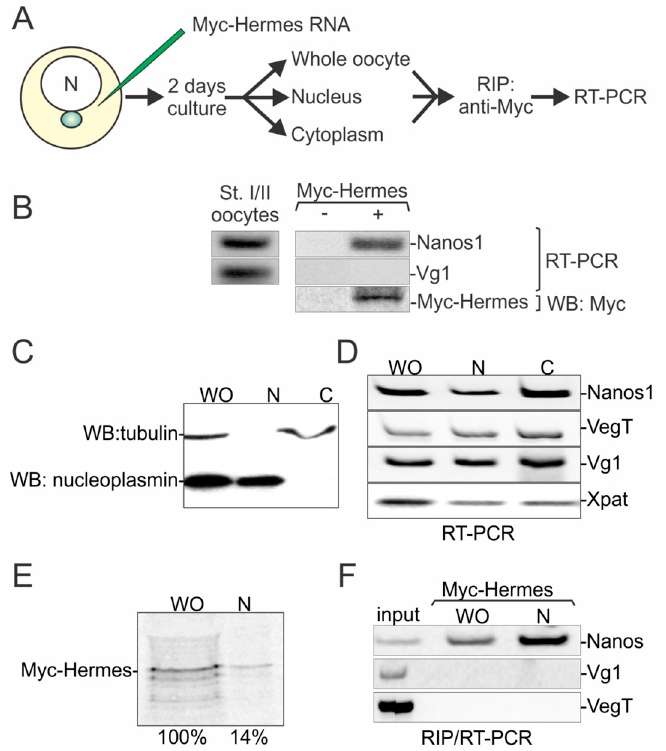
Figure 6. Hermes/Rbpms associates with nanos but not Vg1 RNA in the nucleus. ( A ) Overall experimental design. Myc-Hermes/Rbpms mRNA was injected into stage I/II oocytes. After culturing for two days, either myc-Hermes/Rbpms protein was immunoprecipitated (IP) with anti-myc antibody from whole oocytes only or the nuclear (N) and cytoplasmic (C) fractions were manually isolated before IP with anti-myc antibody. In either design, RNA was extracted from the resulting pellet and analyzed with specific primers for Vg1 or nanos RNA by RT-PCR; ( B ) Myc-Hermes/Rbpms interacts with nanos but not Vg1 RNA in vivo . Control RT-PCR with whole oocytes shows that nanos and Vg1 RNAs were present. Control western blot shows that myc-Hermes/Rbpms was translated after injection; ( C ) The nuclear and cytoplasmic fractions were manually isolated from stage I/II oocytes. Tubulin (cytoplasmic marker) and nucleoplasmin (nuclear marker) were detected by western blot analysis and show clean separation; ( D ) Late and Early Pathway RNAs accumulate in nucleus concurrently. RNAs were analyzed by RT-PCR using specific primers; ( E ) Western blot analysis showed newly translated Hermes/Rbpms in the nucleus; ( F ) Hermes/Rbpms interacts with nanos RNA in the nucleus, but not Vg1 or VegT . WO: whole oocyte; Uninjected oocytes served as negative controls. Blue sphere (MC); N